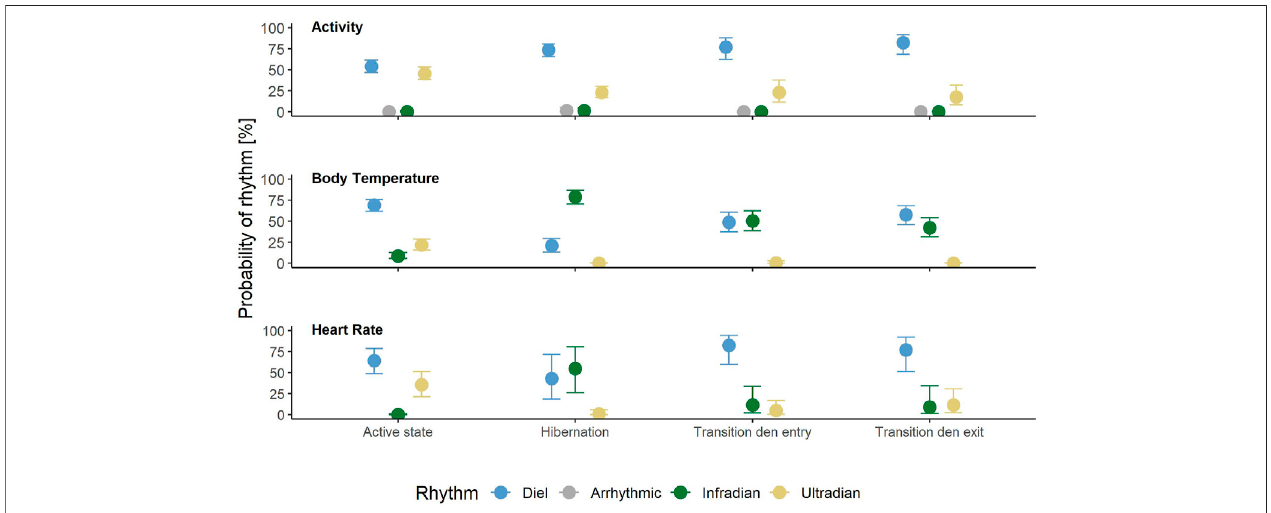
FIGURE 3 | Probabilities of showing diel (blue), arrhythmic (grey), infradian (green) or ultradian (yellow) rhythms in body temperature, heart rate and activity in Scandinavian brown bears by time period (active period, hibernation, transition around den entry and den exit). Error bars indicate 95% credible intervals.